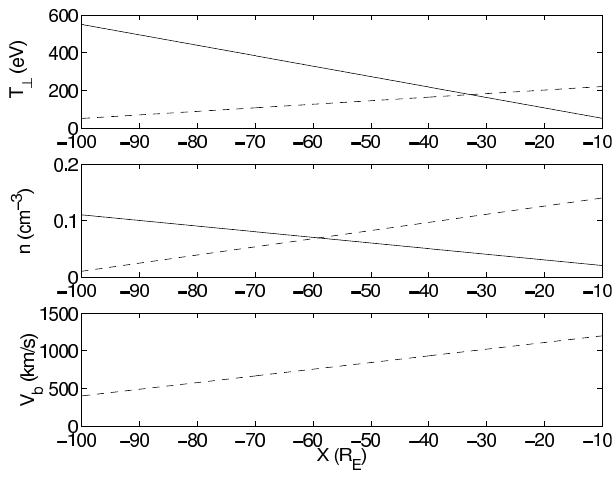
Fig. 9. Model variables against downtail position for (top) the perpendicular temperature ( T ⊥ ), (middle) number density (n), and (bottom) velocity ( V b ) are shown for the core term (solid curves) and the beam term (dashed